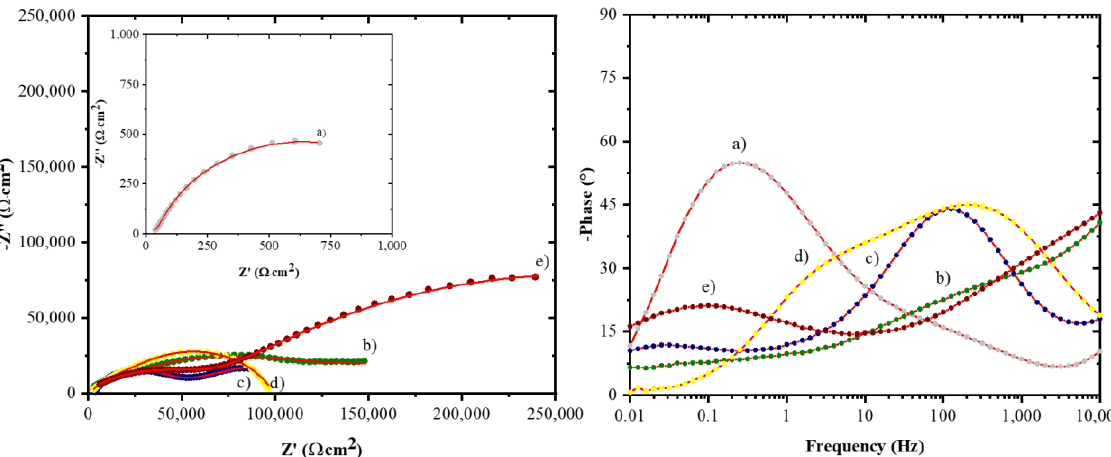
Figure 11. Nyquist and Bode diagrams of: ( a ) uncoated 1018 steel (gray) and coatings of ( b ) PANI/AR (olive green), ( c ) SiO 2 -PANI/AR (blue), ( d ) CeO 2 -PANI/AR (yellow), and ( e ) TiO 2 A-PANI/AR (burgundy). The continuous line represents the fit of experimental diagrams.